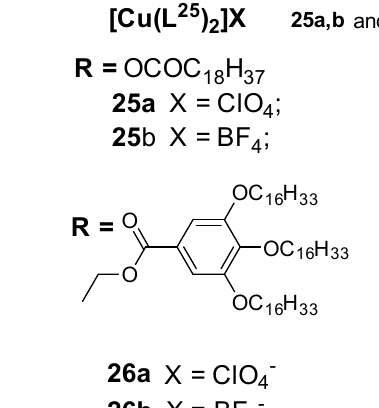
Figure 12. Copper(I) complexes with bisubstituted biquinoline ligands [60].